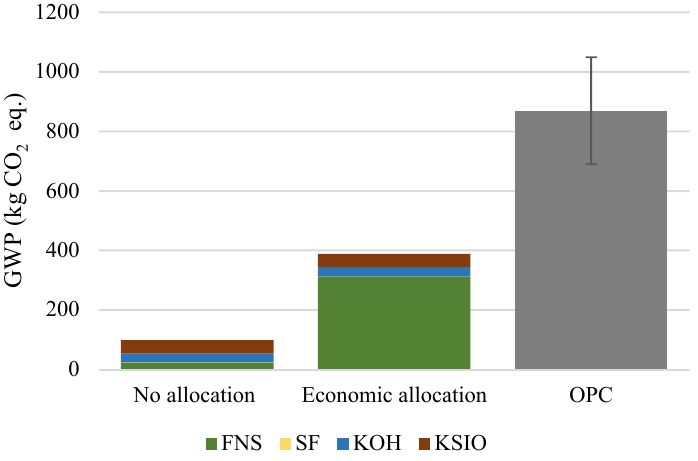
Figure 12. Impact of the allocation method on the total GWP of FNS AAM compared to OPC.